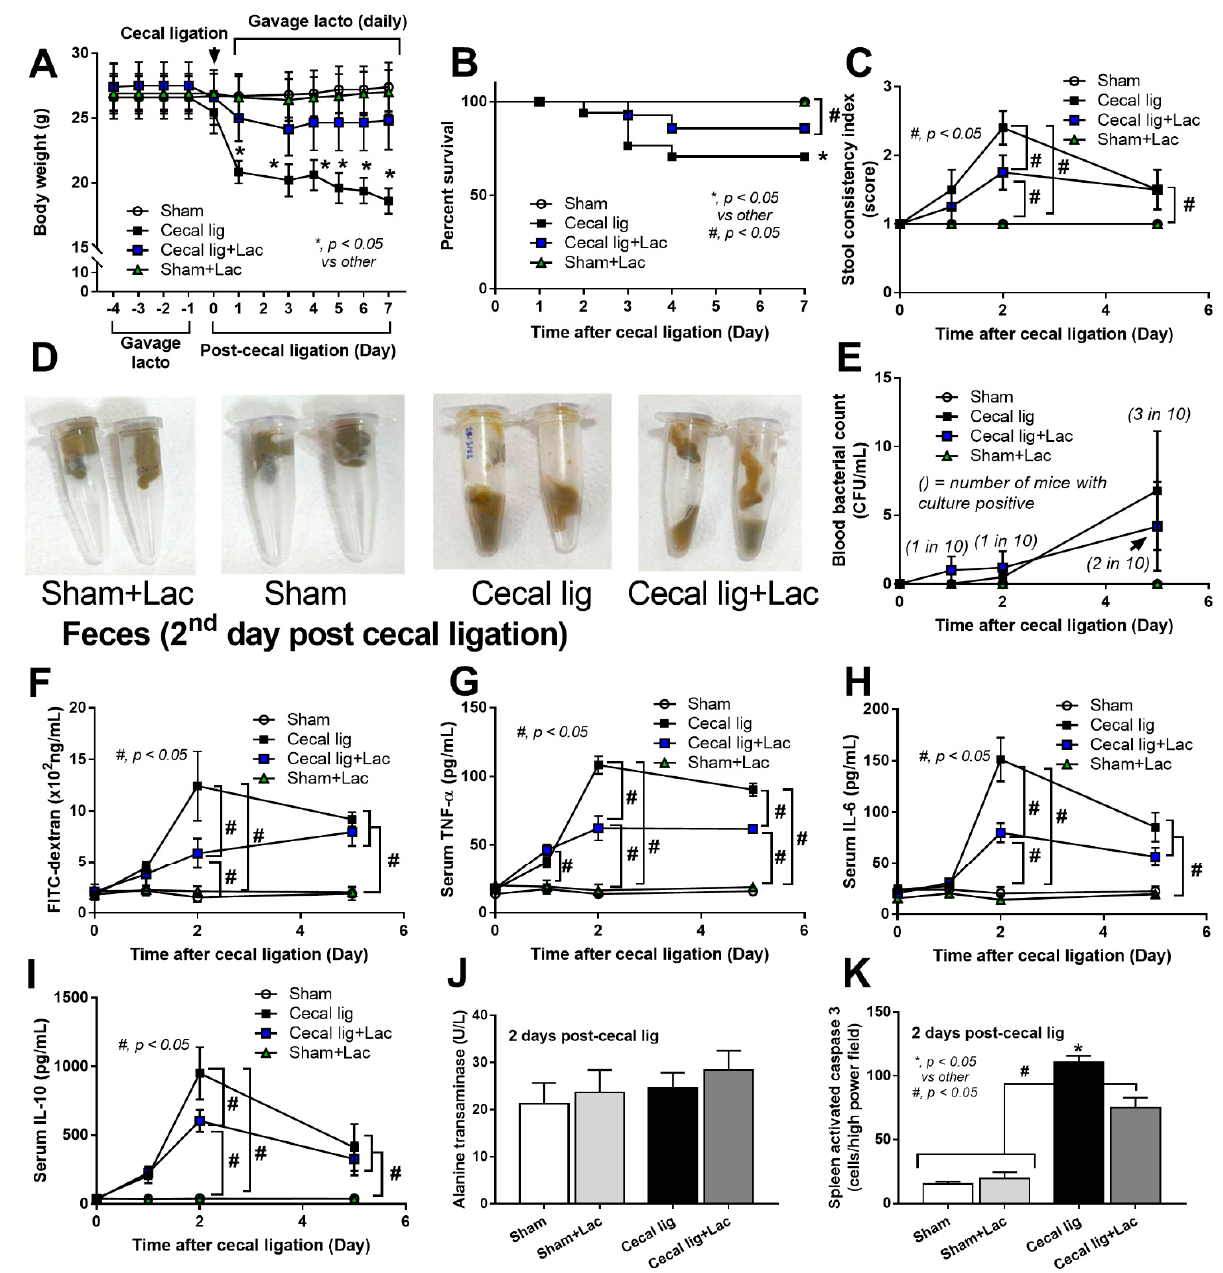
Figure 1. The characteristics of mice with cecal ligation (without puncture) (Cecal lig) or sham surgery (Sham) with or without Lacticaseibacillus administration (Cecal lig + Lac and Sham + Lac) as indicated by body weight ( A ), survival analysis ( B ), stool consistency index ( C ), representative pictures of the mouse feces ( D ), blood bacterial count ( E ), gut barrier determination (FITC-dextran assay) ( F ), serum cytokines (TNF- α , IL-6, and IL-10) ( G – I ), liver enzyme (alanine transaminase) ( J ), and spleen apoptosis ( K ) are demonstrated (n = 25/group in A and B, n = 8–10/group or time point for others).